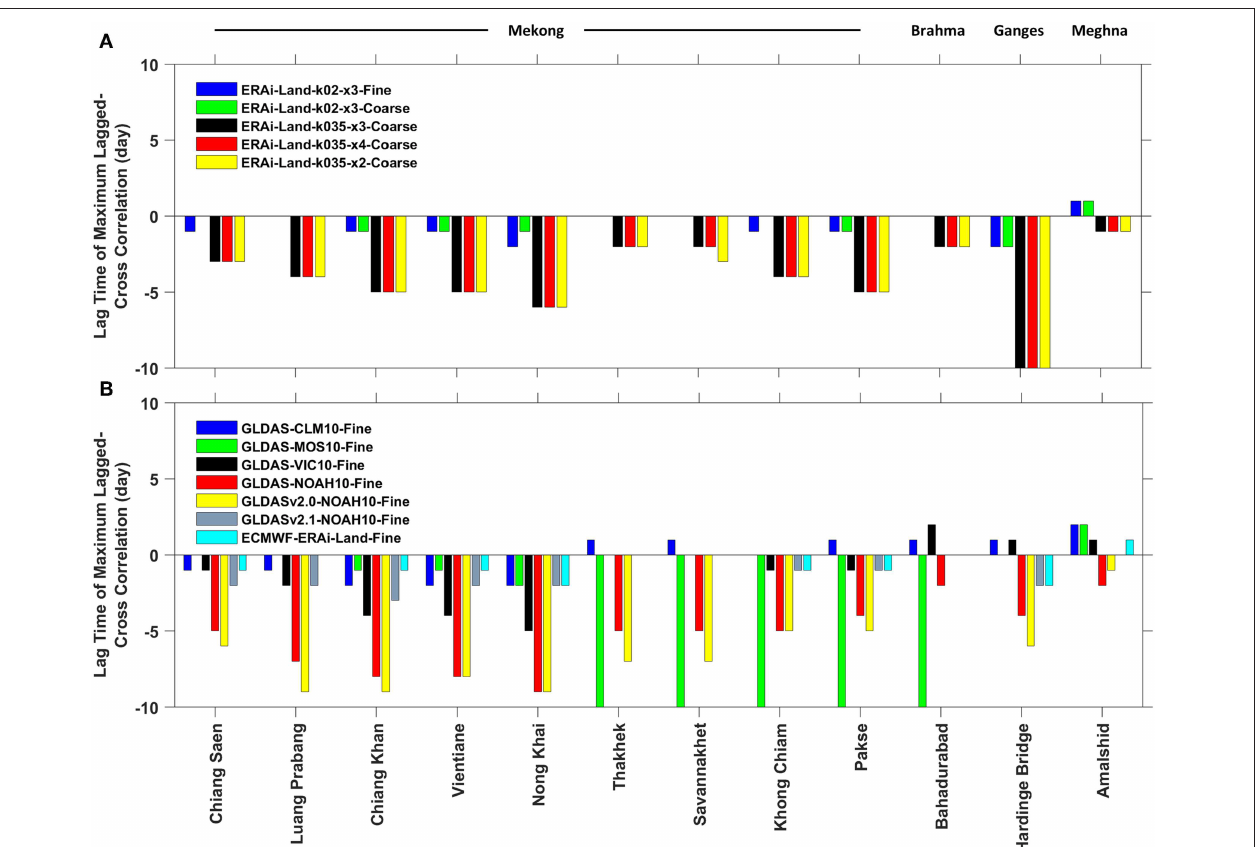
FIGURE 9 | Lag time corresponding to the maximum lagged cross correlation in between the observed and simulated flow at different locations of the Mekong and GBM basins, as a function of different (A) routing model parameters, (B) LSMs and input forcing.